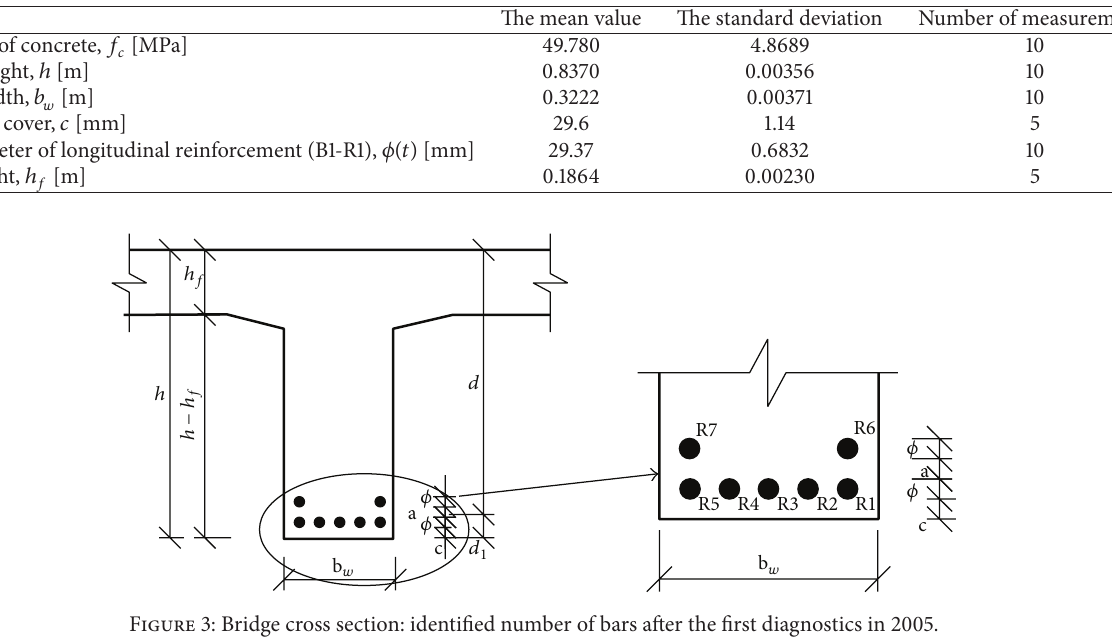
Table 1: Measured values of geometric and material characteristics.